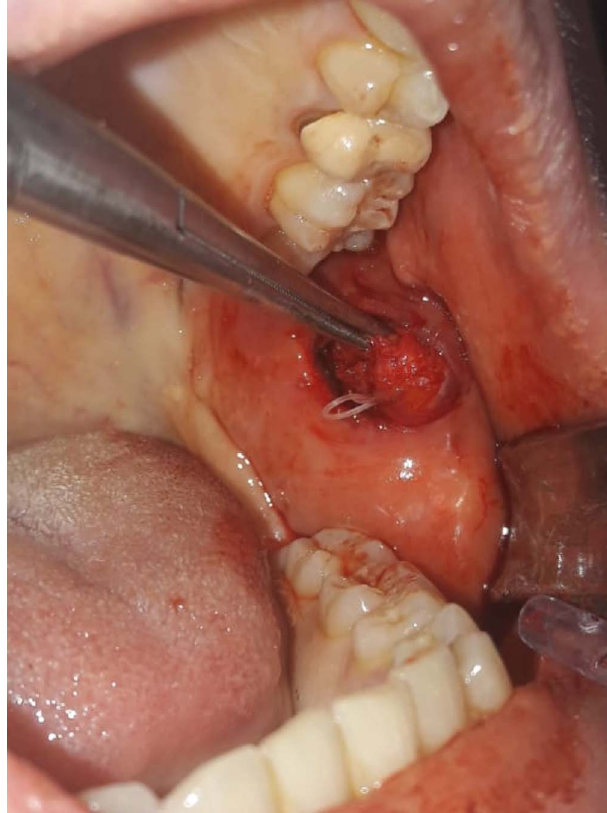
Figure 1. Per-operative photo of the removal of the worm ( Diro fi laria (Nochtiella) repens Railliet & Henry, 1911) from a sub-mucosal nodule in the